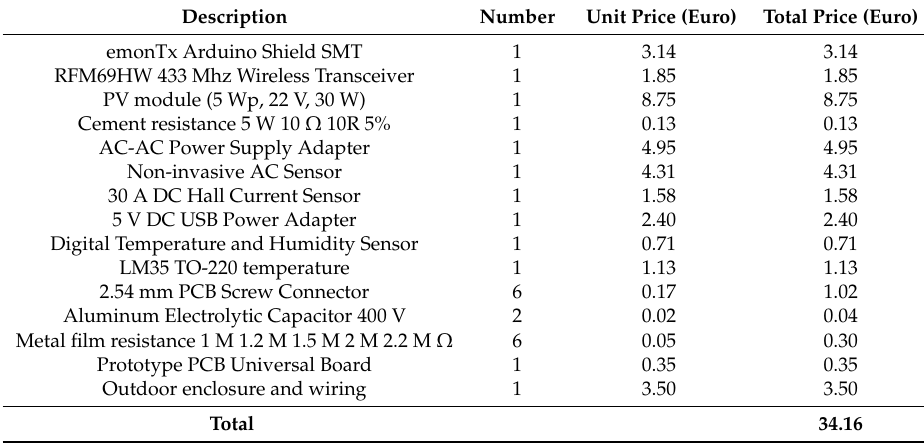
Table 3. PV module and meteorological data: monitoring node cost.